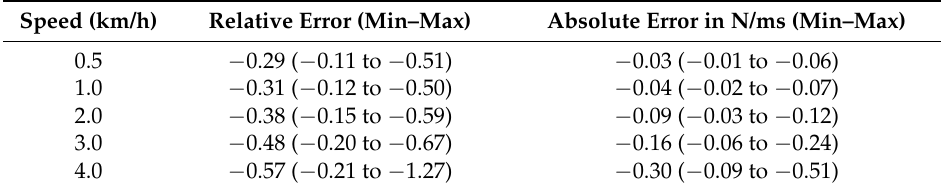
Table 2. Average relative and absolute error in loading rates (n =